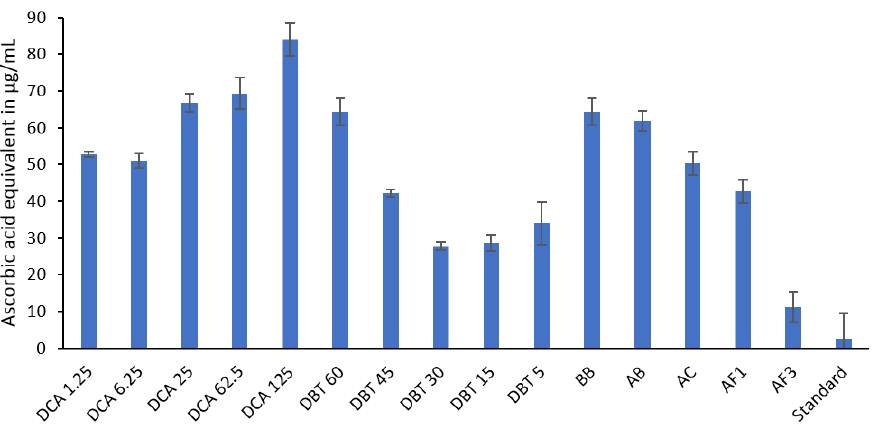
Figure 4. Ascorbic acid equivalent antioxidant capacity in Aronia berry-infused beers.